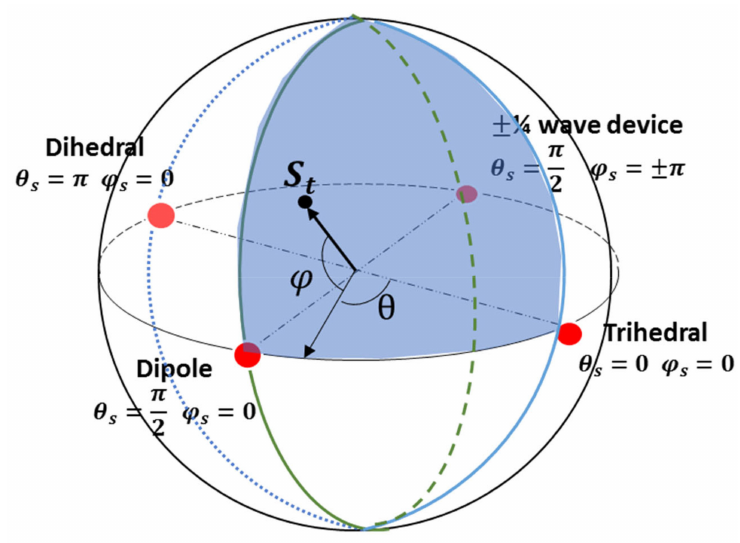
Figure 4. The new spherical topology constructed based on the complementary nature of elementary scattering